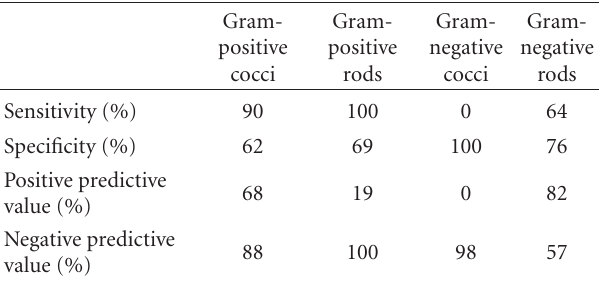
Table 3: Clinical usefulness of Gram staining.